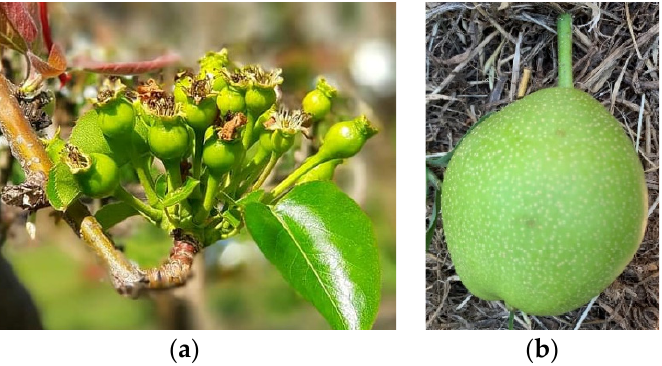
Figure 3. ( a ) Typical fruit set in ‘Nijisseiki’. Photo credit: Steven Singh, Seeka Australia Pty Ltd. ( b ) Elongated fruit shape from the first opening flower in the cluster. Photo credit: Sally Bound, TIA.